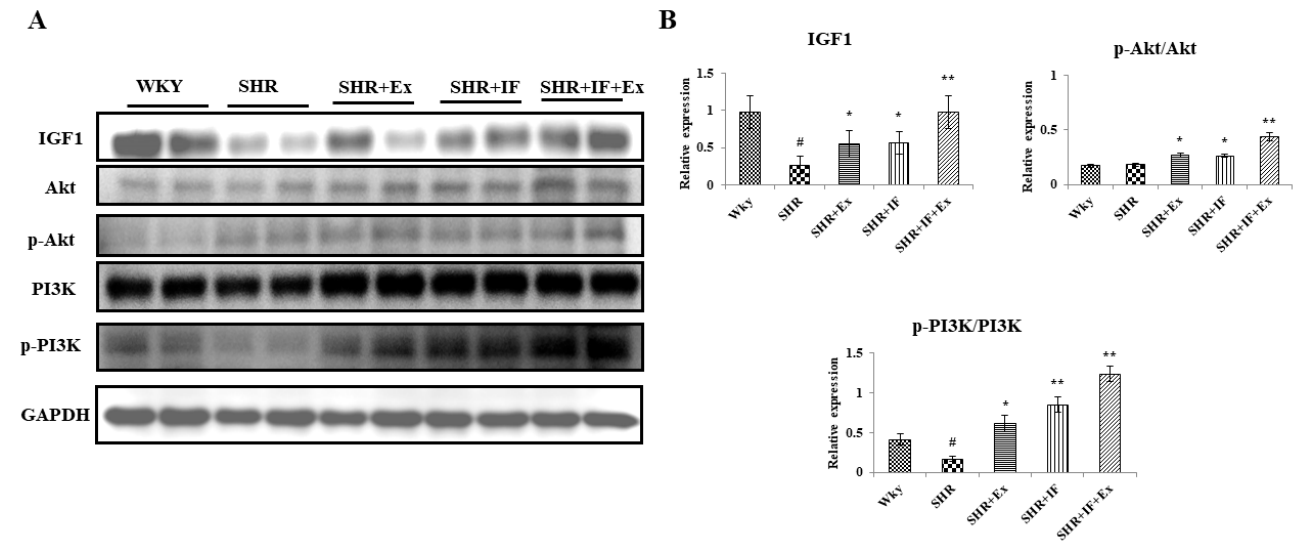
Figure 8. Effect of IF and exercise training on the cell survival pathway in the heart tissue section of SHR animals. ( A ) Expression of survival protein. IGF1, insulin-like growth factor 1; PI3K, phosphoinositide 3-kinases; AKT, protein kinase B. ( B ) Densitometric analysis of relative protein expression, normalized with internal control GAPDH. n = 8, # p < 0.01 compared to WKY, * p < 0.05, and ** p < 0.01 compared to SHR.